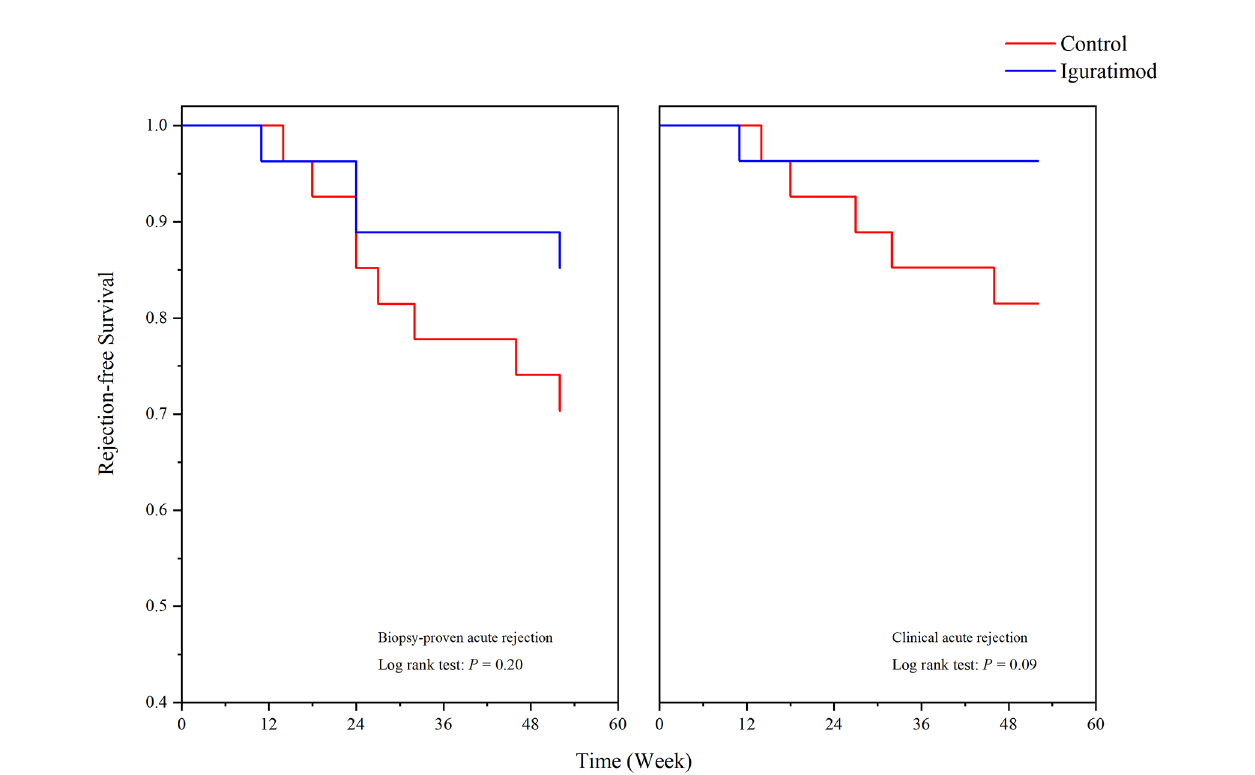
FIGURE 2 | One-year rejection-free survival in Iguratimod and control groups. Biopsy proved acute rejection (BPAR, left) and clinical acute rejection (right) were shown respectively. No statistical signi fi cance was detected ( P = 0.20 for BPAR, and P = 0.09 for clinical rejection).